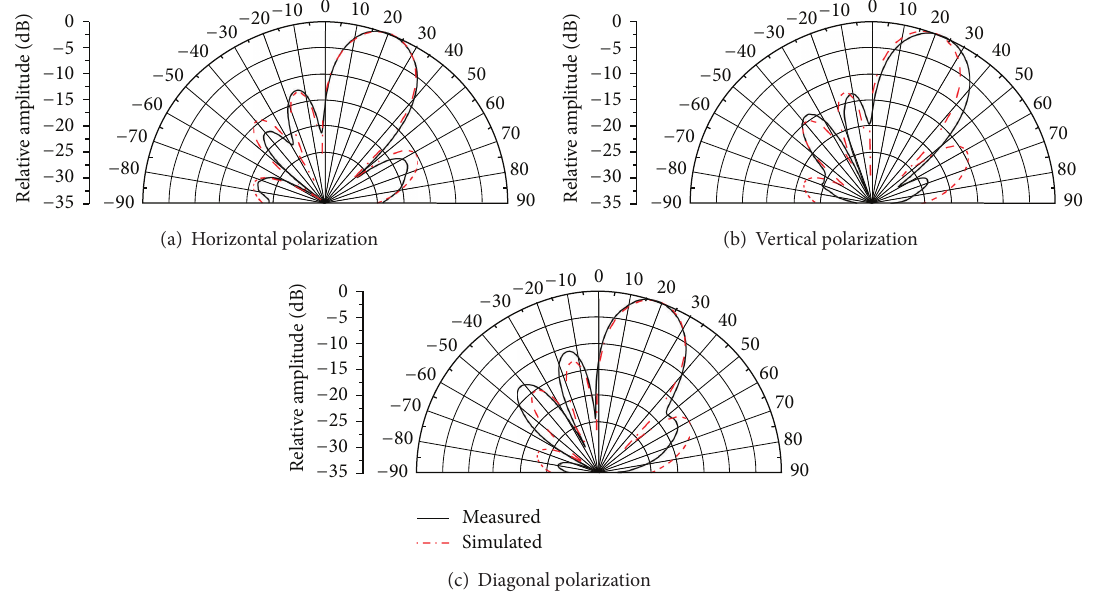
Figure 17: The polarization tracking patterns measured at 12.5 GHz with beam scanned to 20 ∘ .